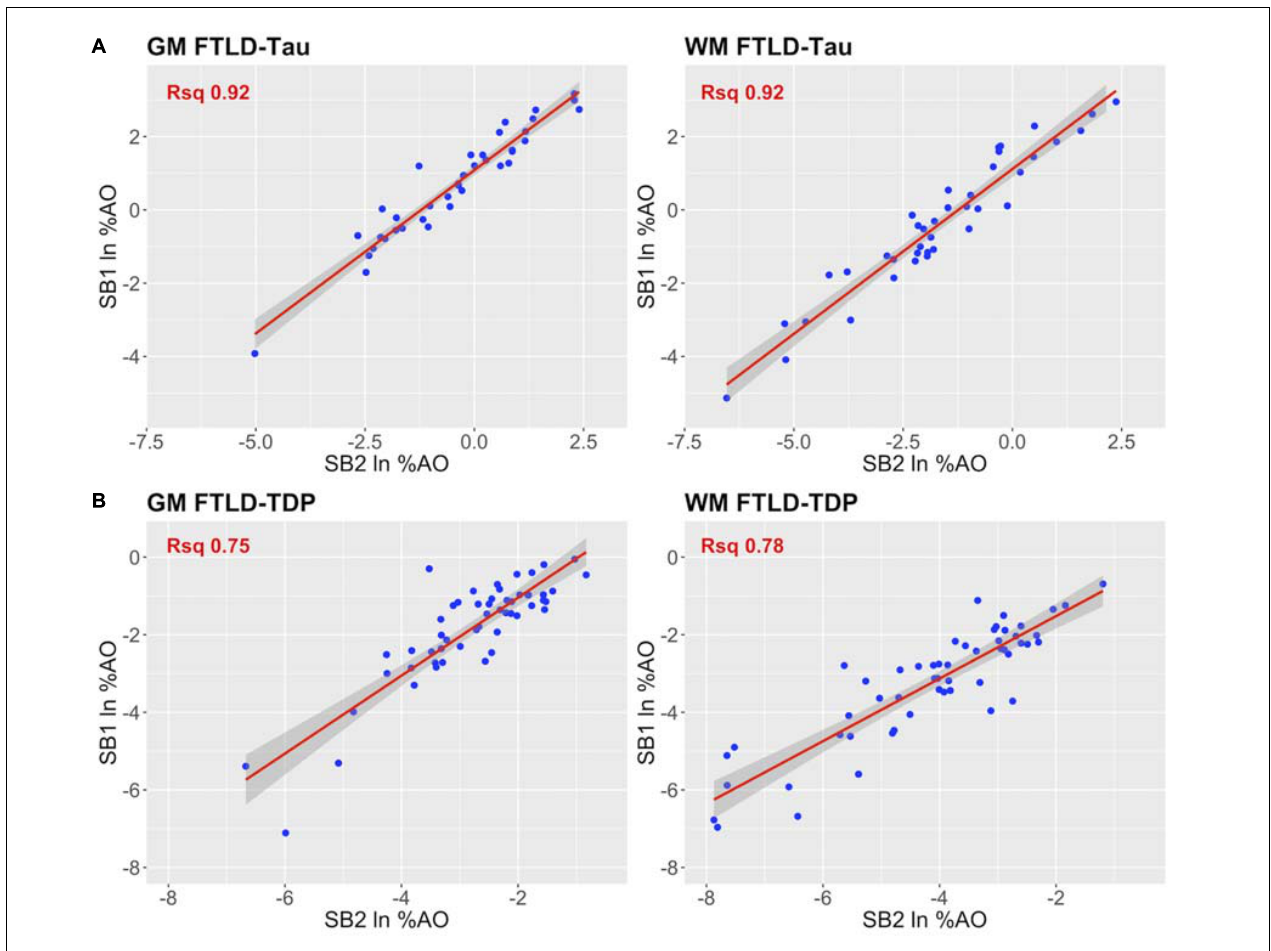
FIGURE 4 | Linear relationship between duplicate measurements of pathology from two distinct staining batches (SB1 Y -axis, SB2 X -axis). Scatterplots display the linear relationship between duplicate measurements of digital pathology (i.e., ln %AO) from SB1 ( y -axis) and SB2 ( x -axis) in FTLD-Tau (A) and FTLD-TDP (B) , for both GM and WM measurements. In FTLD-Tau GM, the model Rsq is 0.92 ( p < 0.001); in FTLD-Tau WM, the model Rsq is 0.92 ( p < 0.001). In FTLD-TDP GM, the model Rsq is 0.75 ( p < 0.001); in FTLD-TDP WM, the model Rsq is 0.78 ( p < 0.001). FTLD-Tau, frontotemporal lobar degeneration with inclusions of the tau protein; FTLD-TDP, frontotemporal lobar degeneration with inclusions of the transactive response DNA-binding protein 43 kDa; GM, gray matter; ln %AO, natural logarithmic transformation of percent area occupied by pathology; Rsq, R squared; SB1, staining batch 1 (original); SB2, staining batch 2 (new); WM, white